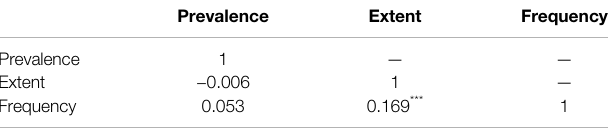
TABLE 7 | Bivariate correlations among supplement use patterns from